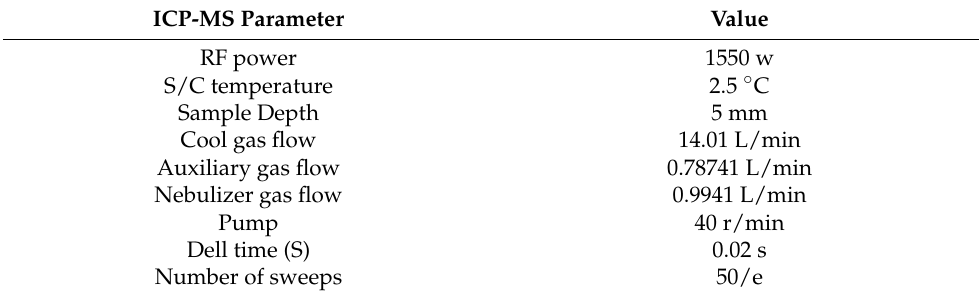
Table 1. Typical operating conditions for the iCAP-Qc used throughout the study.